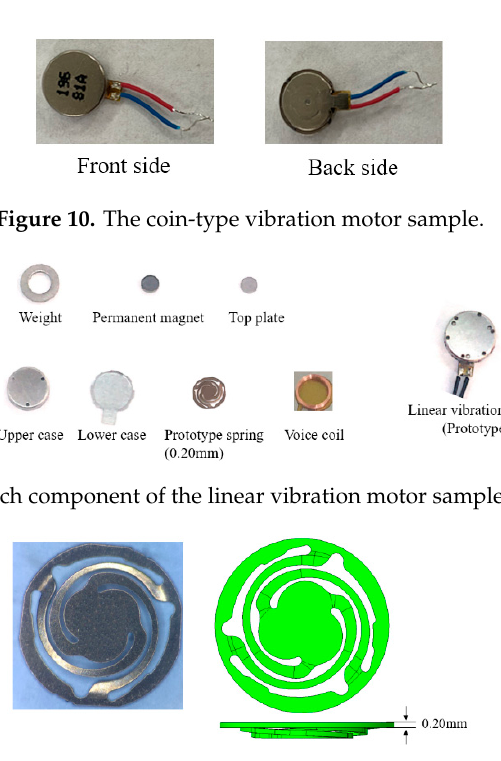
Figure 12. Sample and 3D model of the prototype spring (thickness = 0.20 mm).